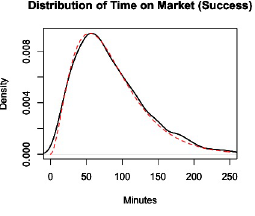
Figure 4. Distribution of time in the market, conditional on successfully obtaining heroin. The black line represents the density of the amount of time each customer spent in the market for individual successful market trips based on 100 simulations of the market from days 180 to 365. The dashed red line represents a fitted distribution, which is a Gamma (2.9,0.035) distribution.